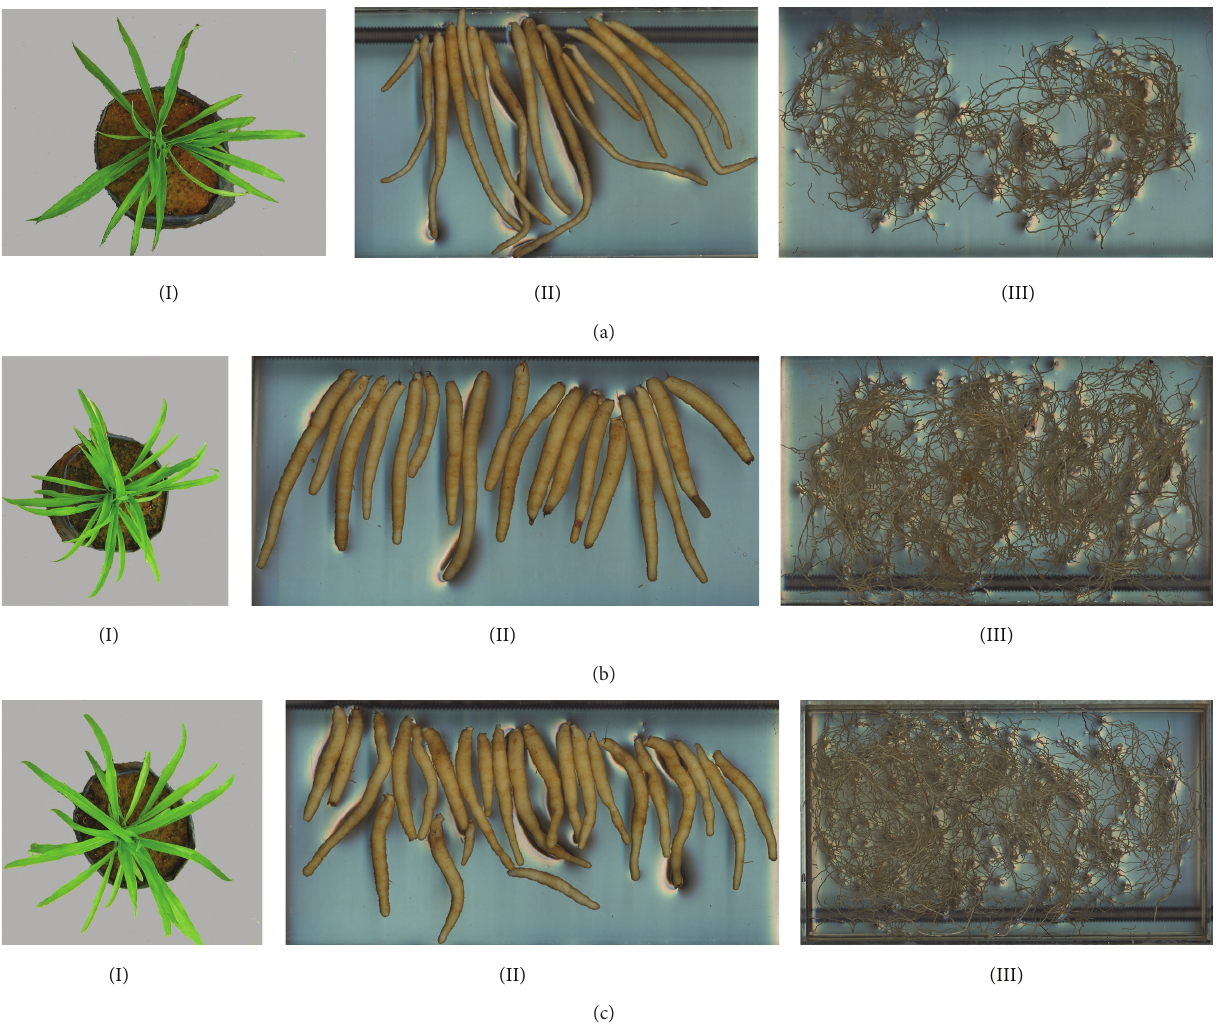
Figure 2: Images of leaves (I), tuberous roots (II), and fibrous roots (III) of safed musli at 90 DAS with (a) for control, (b) for tubers treated with 20mg L −1 GA 3 , and (c) for tubers treated with 15% HA. Tuberous roots from control (a)(II) were less in number and were elongated while tubers treated with 15% HA (c)(II) were significantly higher in number with shorter tuber length. Similarly treated tubers had higher number of leaves (b)(I) and (c)(I) and total fibrous root length (b)(III) and (c)(III) compared to control (a)(I) and (a)(III).